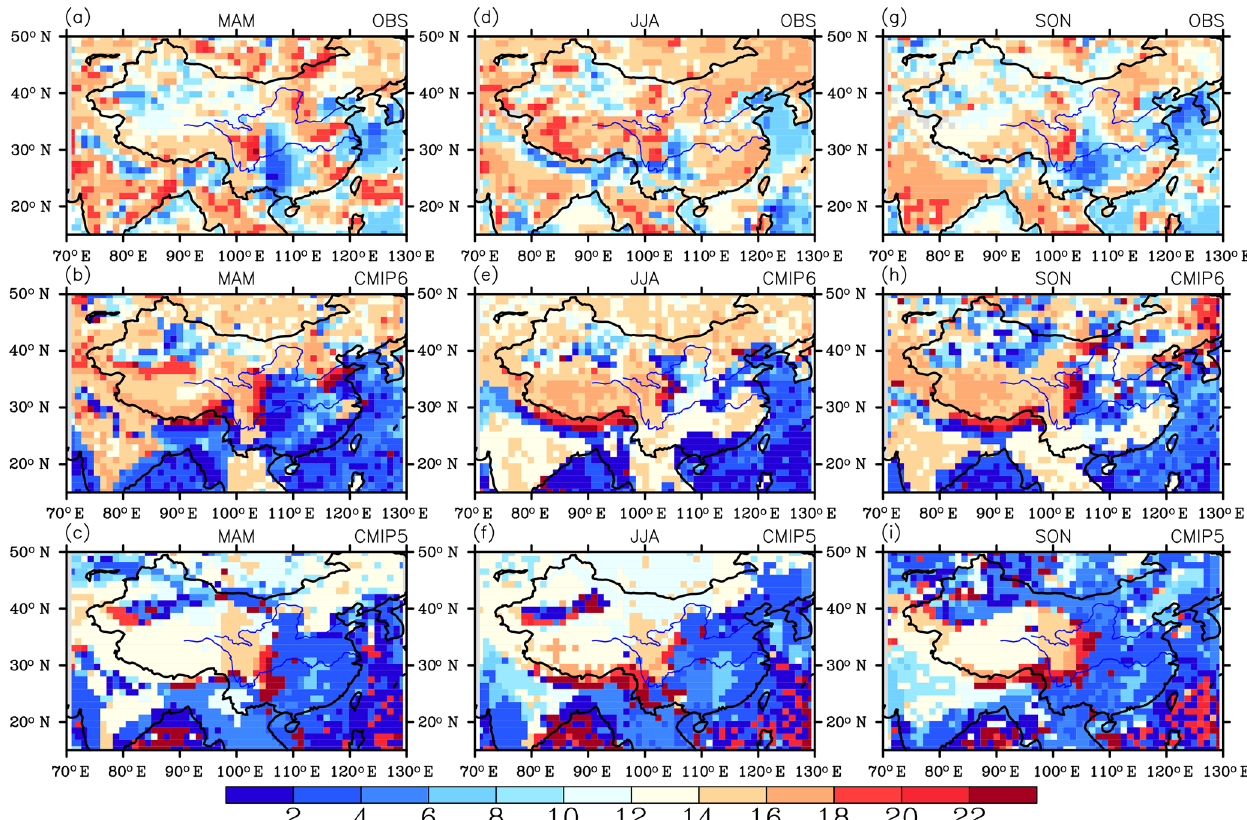
Figure 20. Local times of the maximum frequency of rainfall occurrence in March–April–May (a, b, c) , June–July–August (d, e, f) , and September–October–November (g, h, i) over China and its surrounding areas for BCC-CSM2-MR (b, e, h) , BCC-CSM1.1m (c, f, i) , and TRMM data ( a, d, g , Huffman et al., 2014). The rainfall occurrence is defined as hourly precipitation larger than